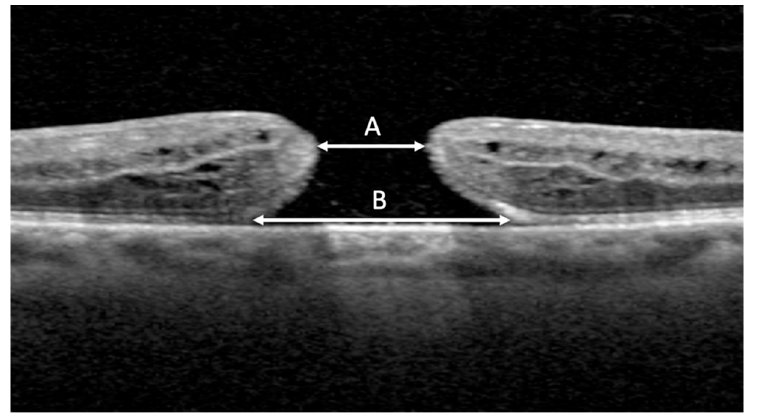
Figure 1. OCT image measurement with distance overlay tool. Minimum linear diameter (MLD) ( A ) was measured between nearest ends of broken macular tissue in the scan with the widest hole dimensions. Basal diameter (BD) ( B ) was measured at the level of the retinal pigment epithelium.